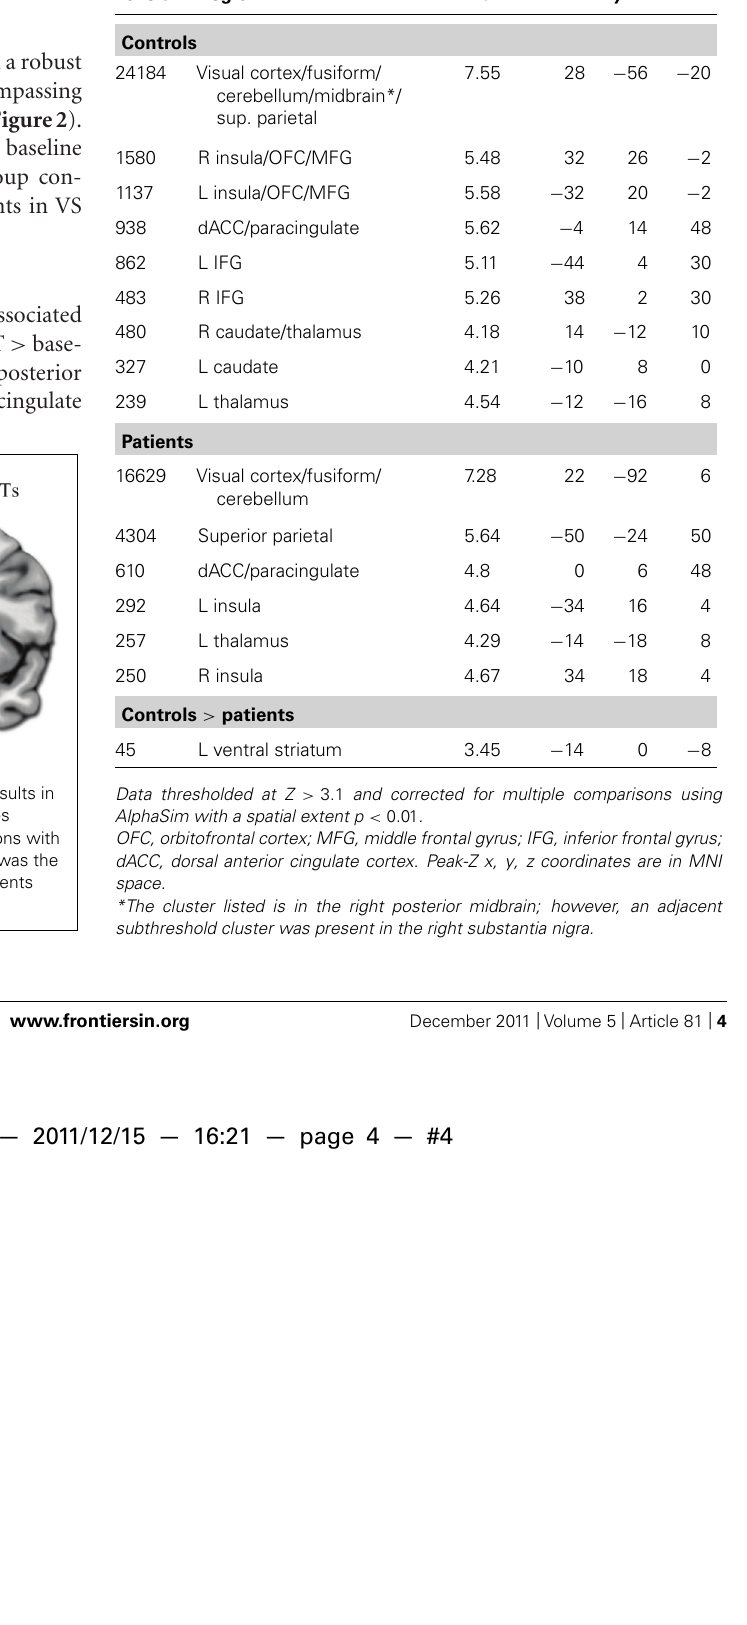
Table 2 | HIT > baseline whole-brain significant clusters.